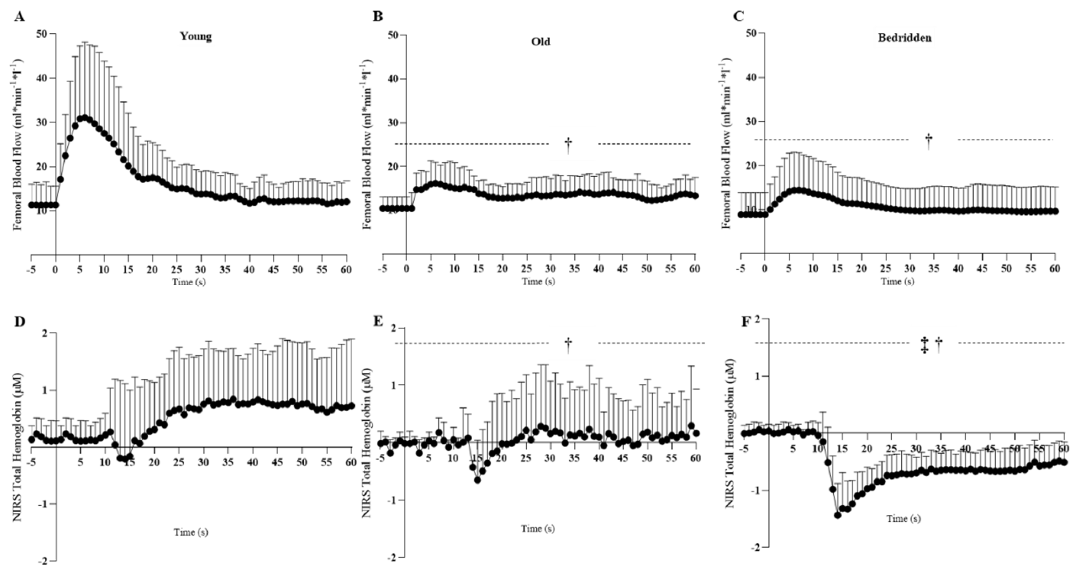
Figure 1. Femoral blood flow and NIRS total hemoglobin during passive limb movement test. Data are presented as mean and standard deviation in the three groups: Young (panel A , femoral blood flow normalized for tight volume; panel D , NIRS total hemoglobin); Old (panel B , femoral blood flow. normalized for tight volume; panel E NIRS total hemoglobin); Bedridden (panel C femoral blood flow normalized for tight volume; panel F , NIRS total hemoglobin). † Between-groups di ff erence versus the Young group ( p < 0.05) ‡ Between-groups di ff erence versus the Old group ( p <